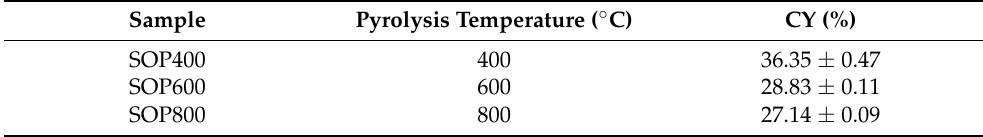
Table 1. Carbonization yield of the pyrolysis process of each temperature